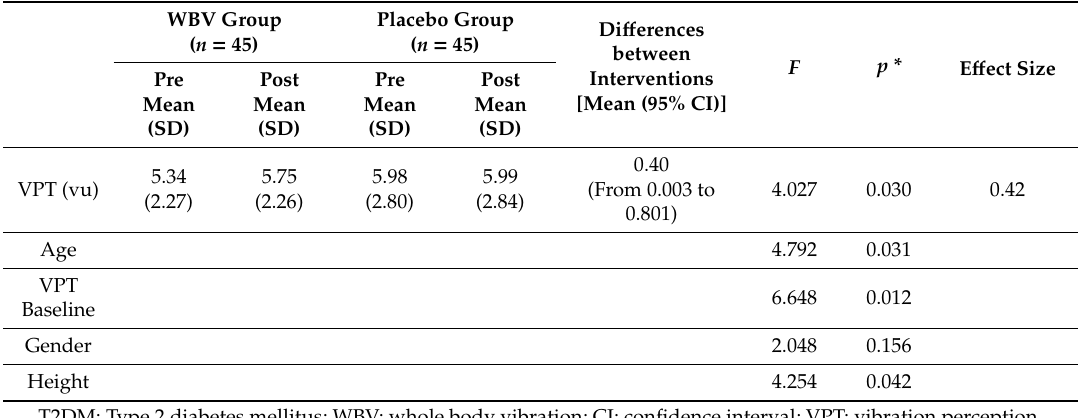
Table 3. E ff ects of a WBV session on the VPT in people with T2DM ( n =